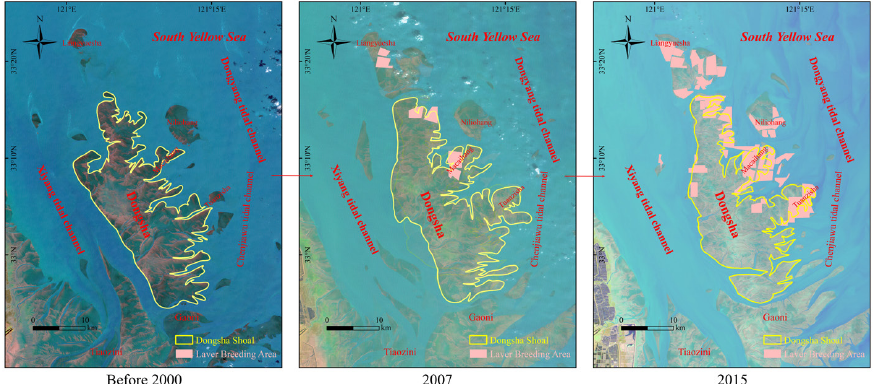
Figure 16. Representation of the water flow cross sections of the Xiyang tidal channel before and after reclamation.